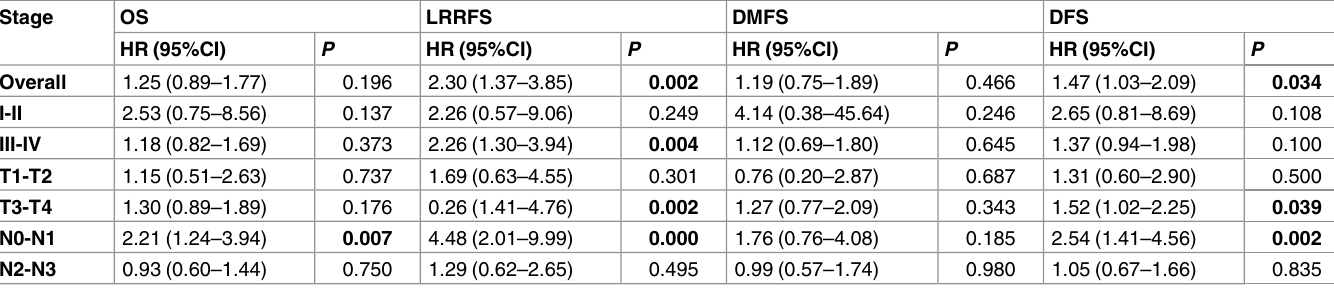
Table 3. Subset analyses on tumor control in the two groups of NDM and